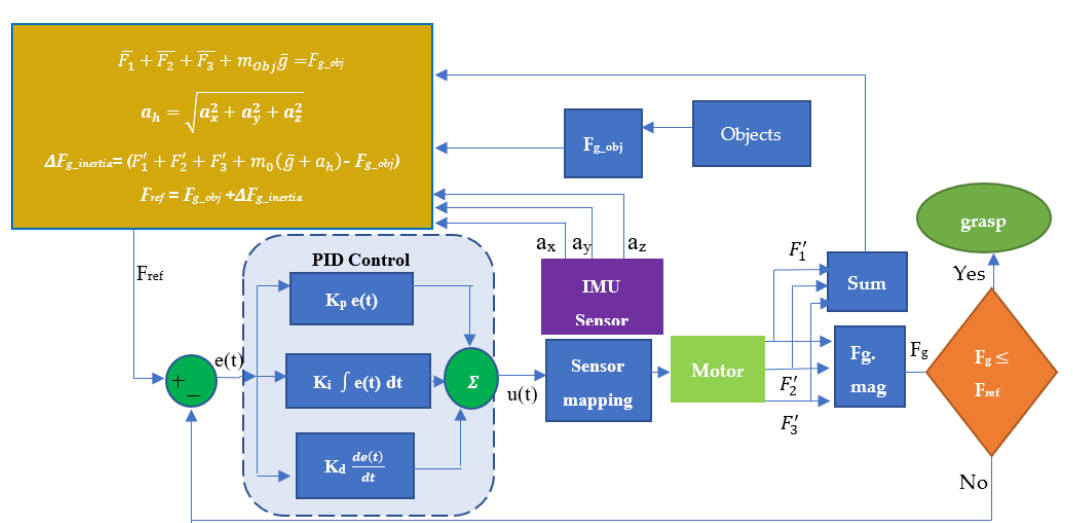
Figure 6. The control scheme for the ExoFinger skeleton.